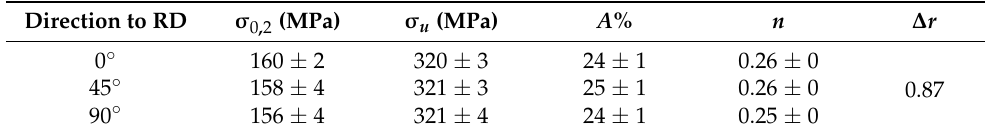
Table 5. Mechanical properties of the Al Mg 6 Mn 0.7 (1565 ch) alloy after annealing at 500 ◦ C (1 h). Direction to RD σ 0 , 2